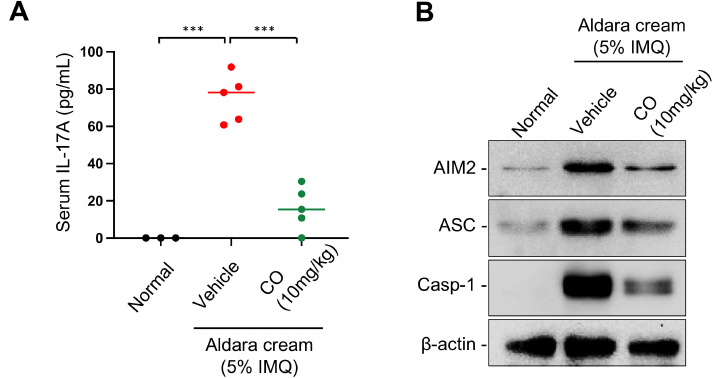
Figure 7. CO reduces IMQ-induced serum IL-17A elevation and the expression of AIM2 inflam- masome components in skin tissue. CO and Aldara cream were applied as described in Figure 6C to obtain serum and prepare skin tissue extracts. ( A ) Serum IL-17A levels measured by an ELISA assay. Data represent the means ± SDs; *** p < 0.001. ( B ) Western blot analysis for the levels of AIM2 inflammasome components in skin